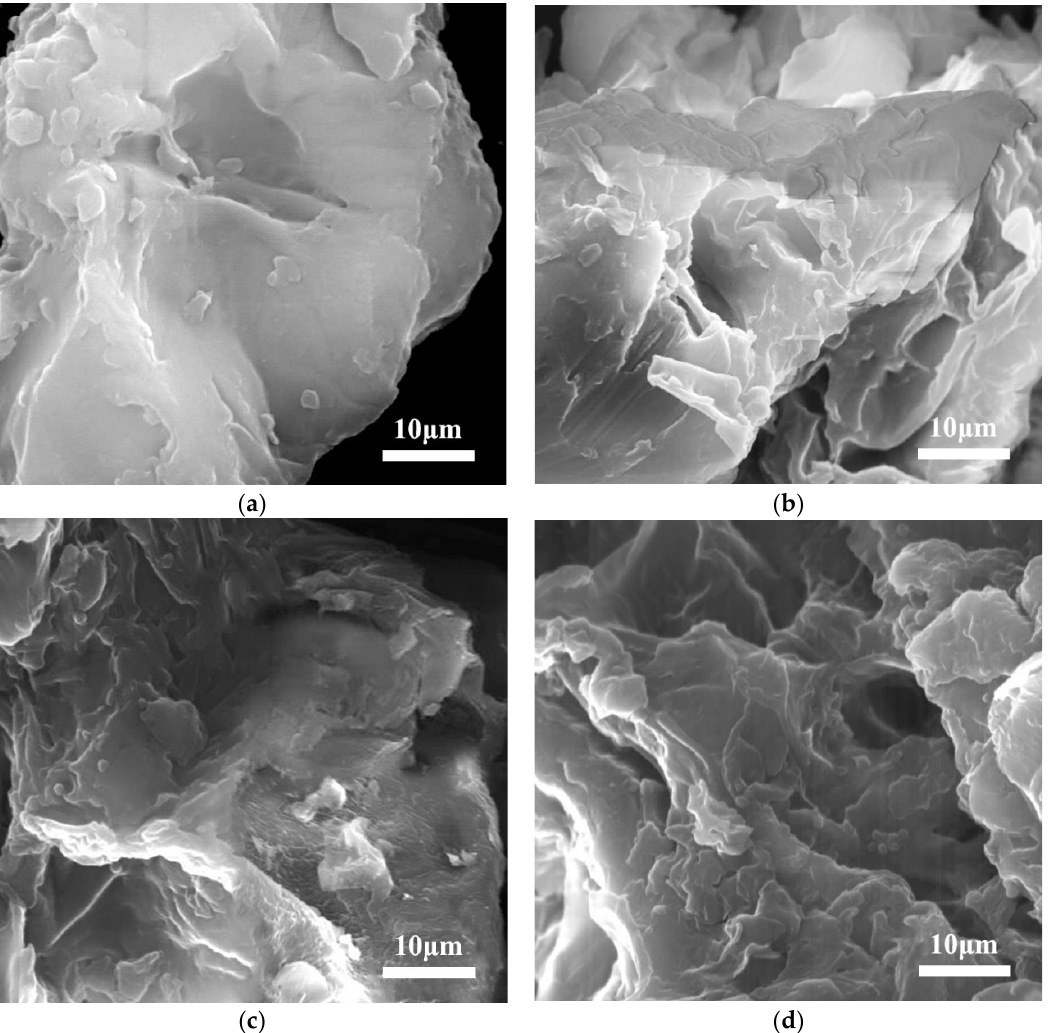
Figure 2. Morphological photos of the PFL powders ( a ) before ultrasonic treatment and after ultra- sonic extraction in ( b ) water, ( c ) ethanol, and ( d ) 70 v / v % aqueous solution of DES-3 baths with a solvent/solid ratio of 30/1 at 28 °C for 30 min.